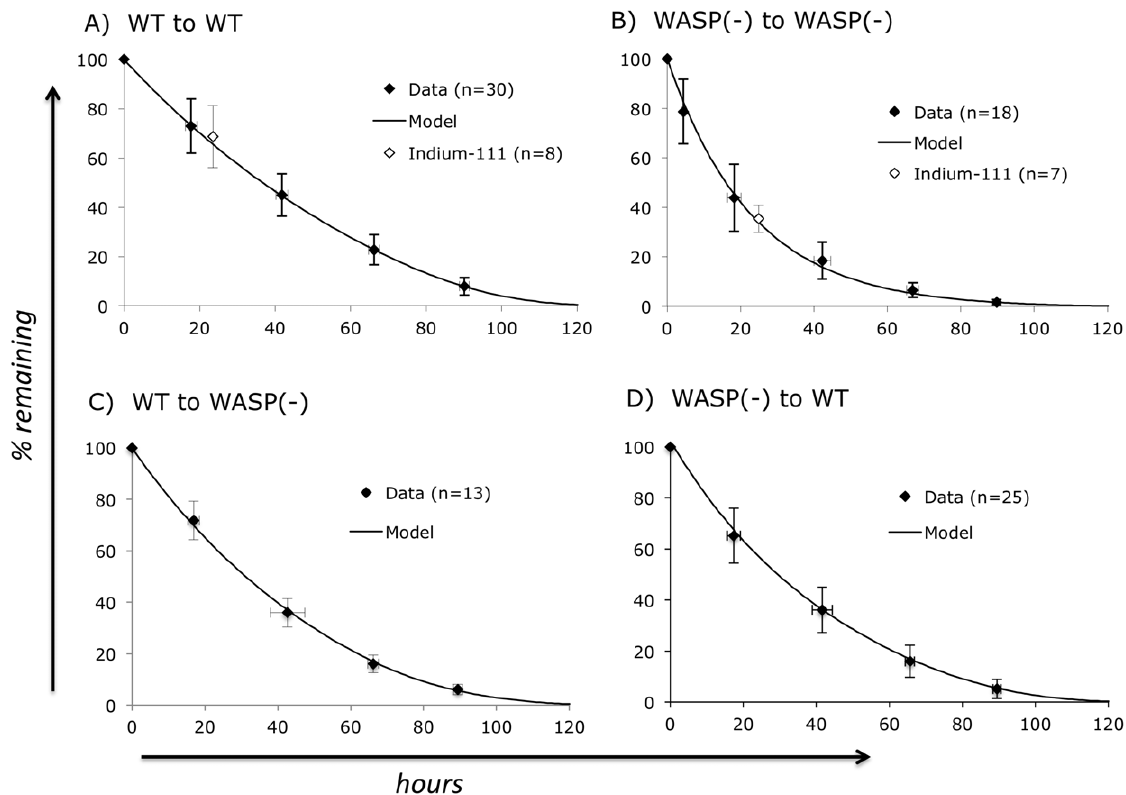
Figure 5. Optimal consumption curves. Black diamonds are data obtained with fluorescently labeled platelets for the ‘‘donor to recipient’’ data sets shown. Consumption curves are shown for the optimal parameter values shown in table 1. For allogeneic platelet consumption curves, the age distribution histograms shown in figure 2 were used to determine the optimal parameter values (see text). Each fluorescently labeled platelet data set includes ‘‘n’’ data points at each of the time points shown, with the exception of the WASP(-) to WASP(-) data set at 5 hours (n=5) and at 89 hours (n=13). Error bars are standard deviations.